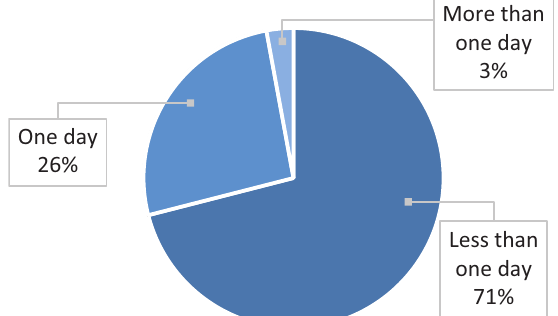
Figure 1. Duration of counter‐trends on the